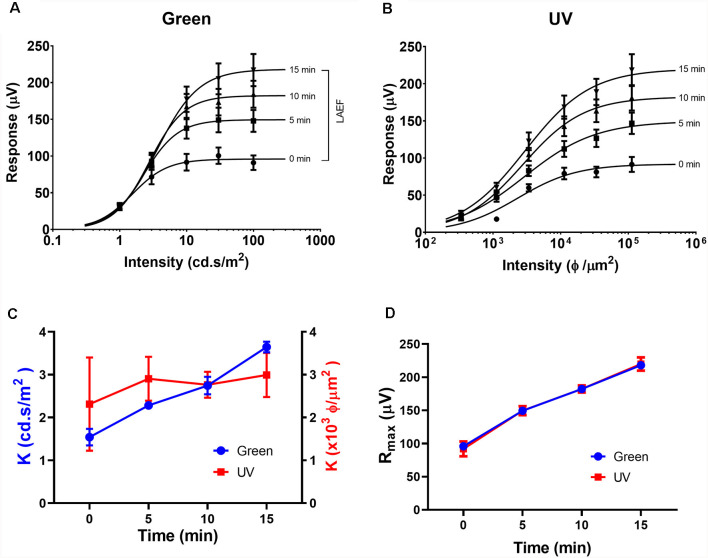
Effects of light adaptation on Green and UV ERG responses. Averaged intensity-response relations for green (A) and UV (B) responses in normal mice (n = 5) elicited at 0, 5, 10, and 15 min after the onset of adapting light. Data were fit with a Naka-Rushton equation. The light adaptation enhancement factor (LAEF) is defined as the ratio of b-wave amplitudes recorded after 15 min light adaptation to those observed at the onset of adapting light (shown as a bracket in A). (C) Effects of light adaptation on the sensitivity factor (K) for responses elicited by green (left axis) and UV (right axis) flashes. (D) Effects of light adaptation on the maximal response amplitude (Rmax) for responses elicited by green and UV flashes.